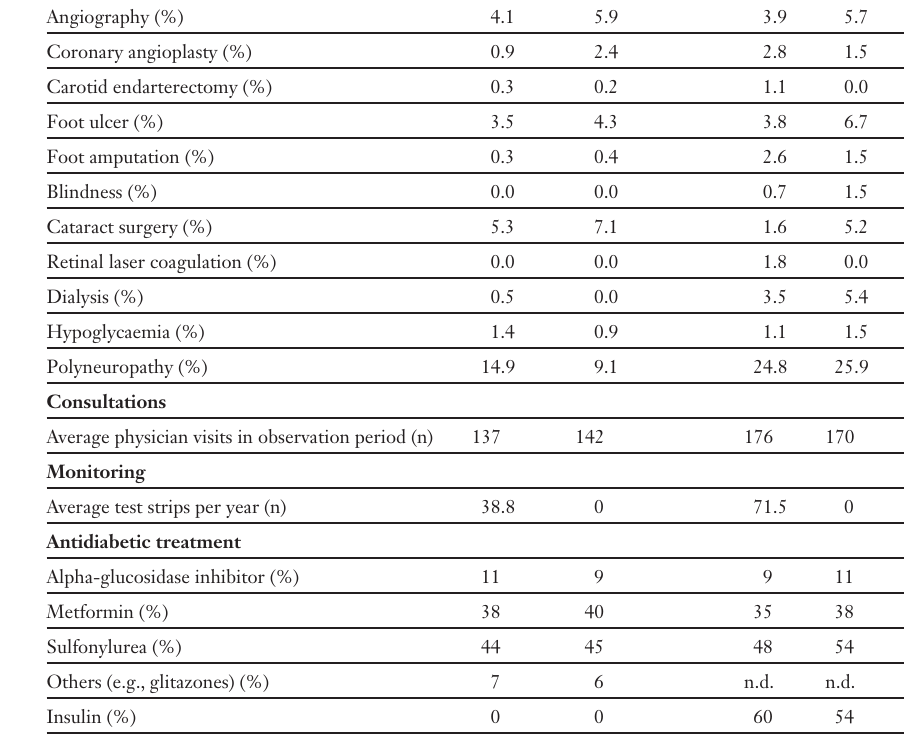
Cost (CHF) of diabetic complications up- dated to